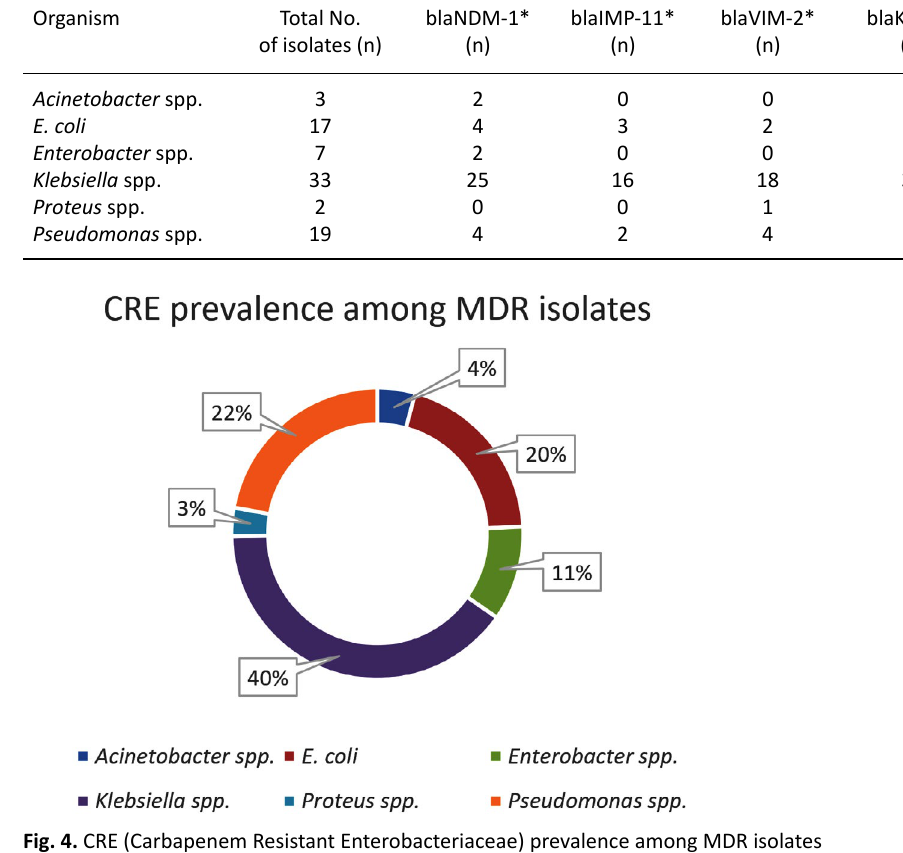
Fig. 4. CRE (Carbapenem Resistant Enterobacteriaceae) prevalence among MDR isolates